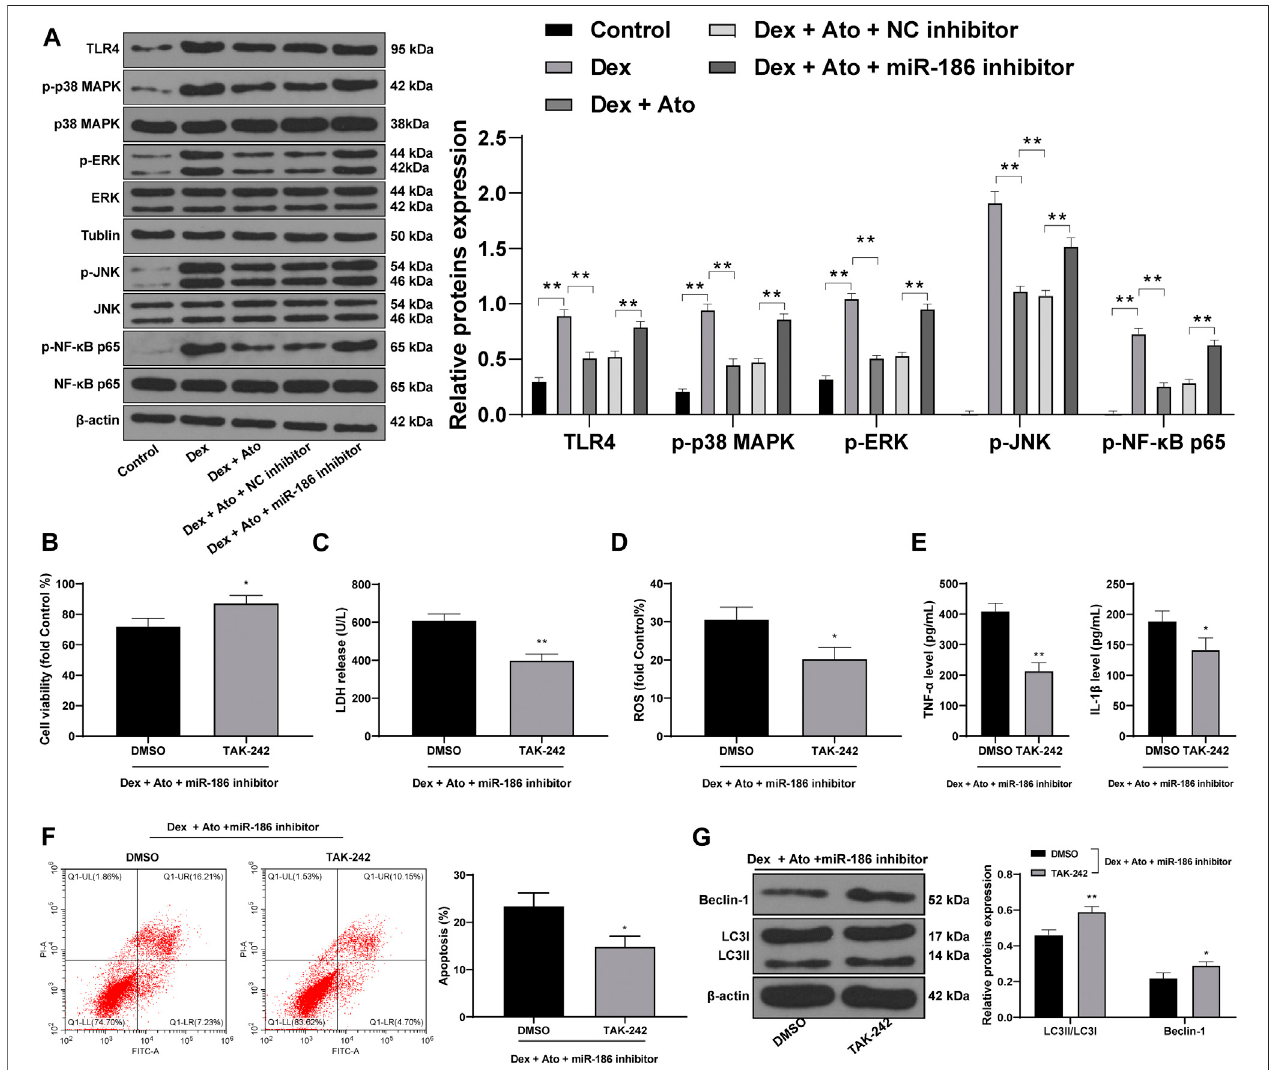
FIGURE 7 | Ato upregulates miR-186 to inactivate the TLR4/MAPKs/NF- κ B axis in DEX-induced OB-6 osteoblasts. (A) the expression of MAPK/NF- κ B pathway- related proteins detected by Western blot; (B) MTT assay detected OB-6 cell viability; (C) Relative LDH release in OB-6 cells was analyzed by LDH assay kit; (D) ROS level inOB-6cells wasmeasuredby DCFH-DA probe; (E) levels ofin fl ammatory cytokines (TNF- α and IL-1 β ) weredetectedby ELISA kits; (F) apoptosis of femoral head was detected by fl ow cytometry; (G) Western blot analysis was used to detect LC3II/LC3I and Beclin-1 expression. Replicates (cid:1) 3. The data are shown in mean ± standard deviation. * p < 0.05, ** p < 0.01, vs. the DEX + Ato + NC inhibitor + DMSO